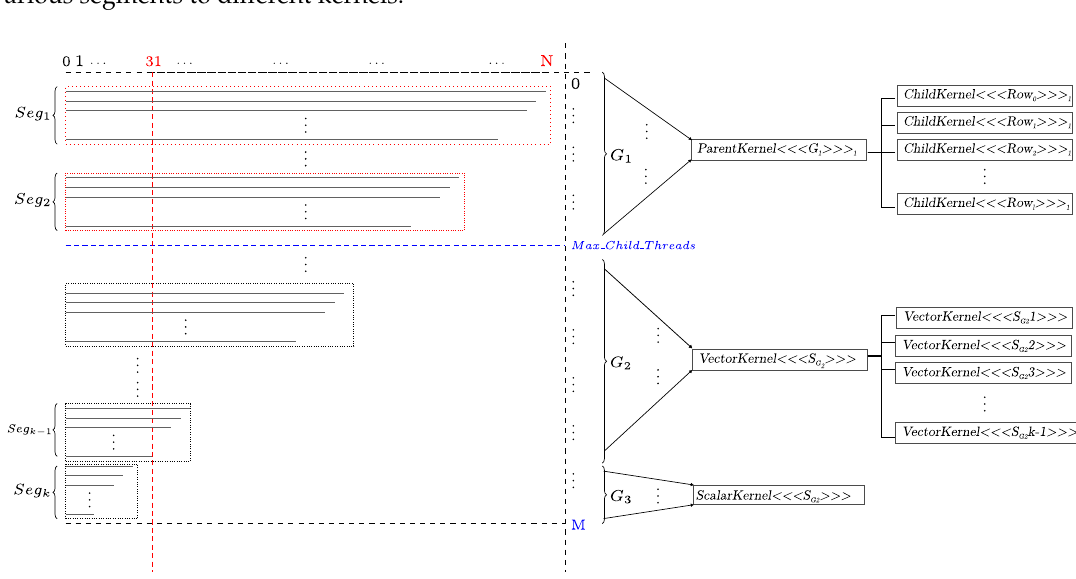
Figure 5. SURAA: Segmentation, grouping, and allocation of kernels among the three groups for the proposed